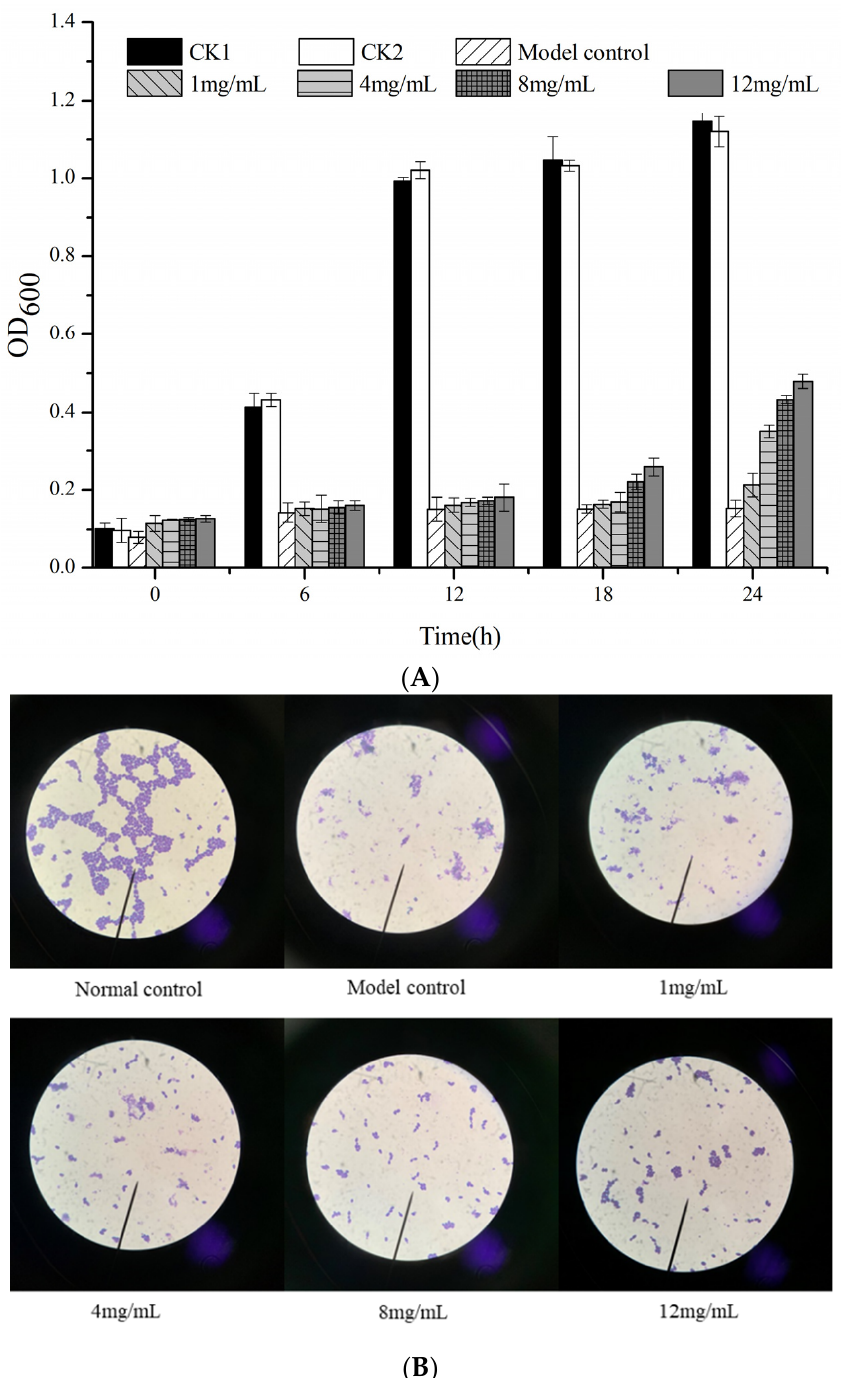
Figure 8. Effect of EPS − 1 from Lc. citreum 1.2461 on yeast protection to oxidative damage in vitro ( A ). Different experimental groups were observed microscopically ( B ).